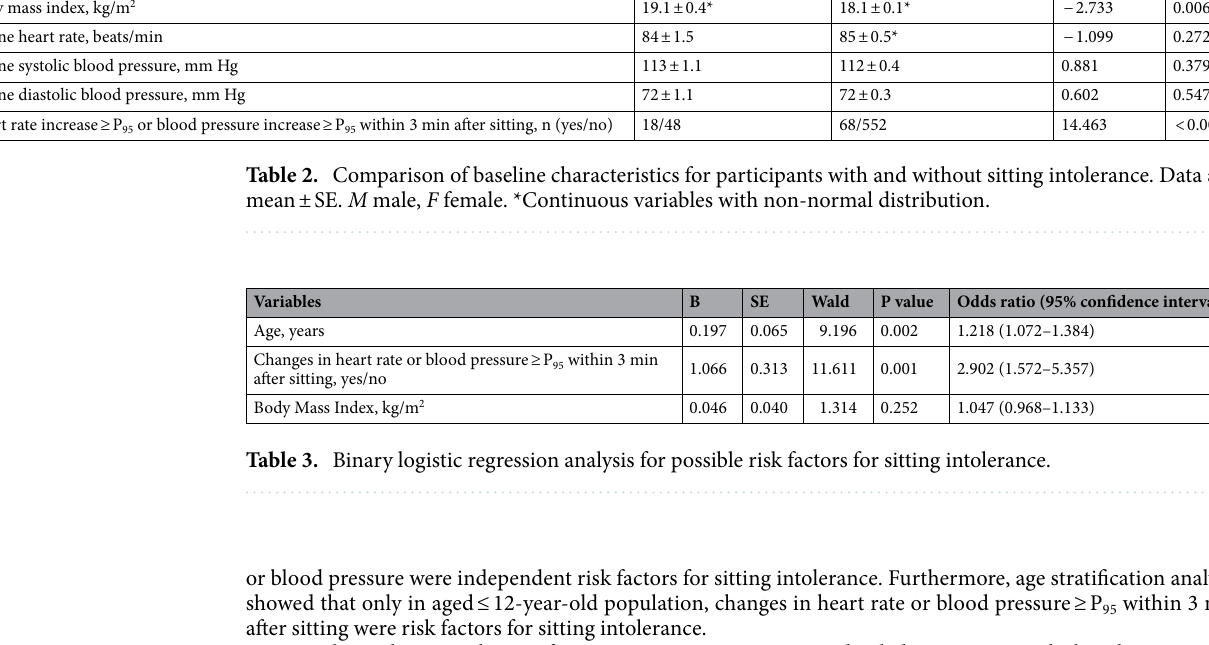
With sitting intolerance Without sitting intolerance χ 2 /Z/t value P value